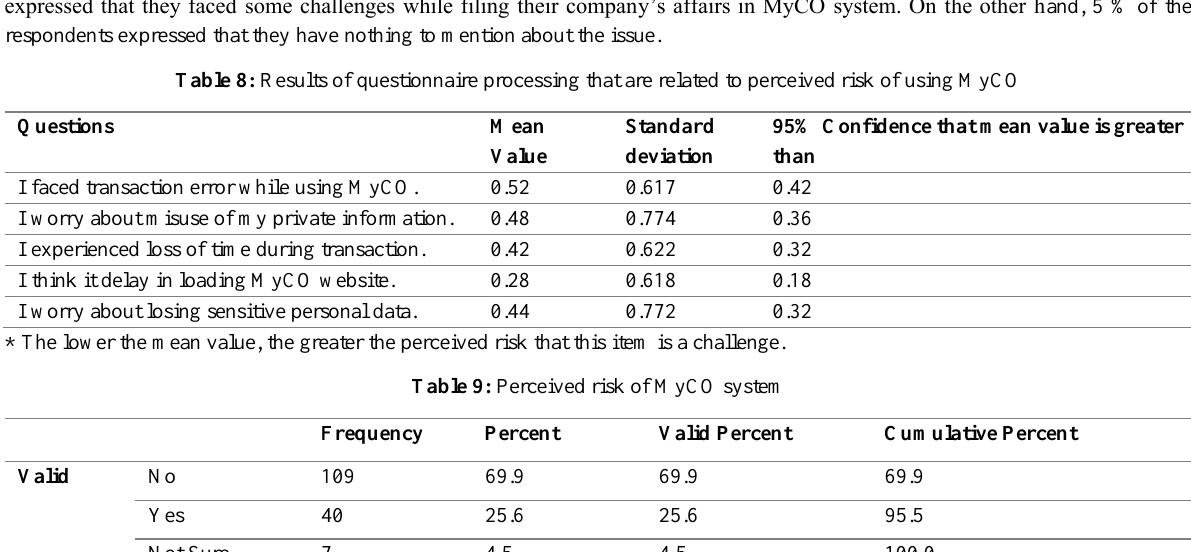
Table 8: Results of questionnaire processing that are related to perceived risk of using MyCO Questions Mean I faced transaction error while using MyCO.